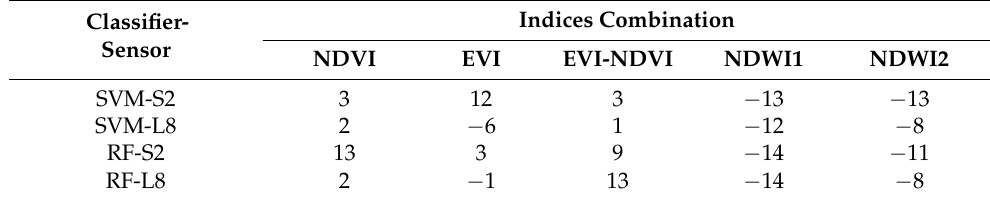
Table 7. Deviation (in %) between the total mapped crop areas and OSS data (280.4 thousand ha). Classifier-